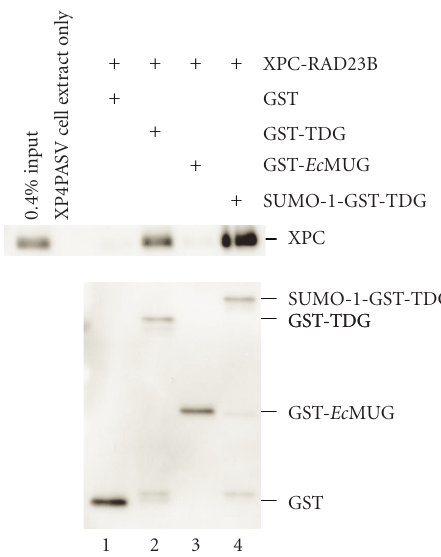
Figure 3: XPC physically interacts with SUMO-1-conjugated TDG, but not with Ec MUG. Glutathione-Sepharose beads (20 μ l) were incubated in 100 μ l of the binding mixture containing 10 nM of GST (negative control), GST-TDG (positive control), GST- Ec MUG, or SUMO-1-GST-TDG in the presence of the same concentration of XPC-RAD23B. After extensive washing, bound proteins were eluted with bu ff er containing 10 mM glutathione. One-fourth of each eluate was mixed with whole cell extract from XP4PASV cells which do not express XPC and subjected to 8% SDS-PAGE followed by immunoblotting with anti-XPC antibody (upper panel). The same samples were also subjected to 12% SDS-PAGE followed by immunoblotting with anti-GST antibody (lower